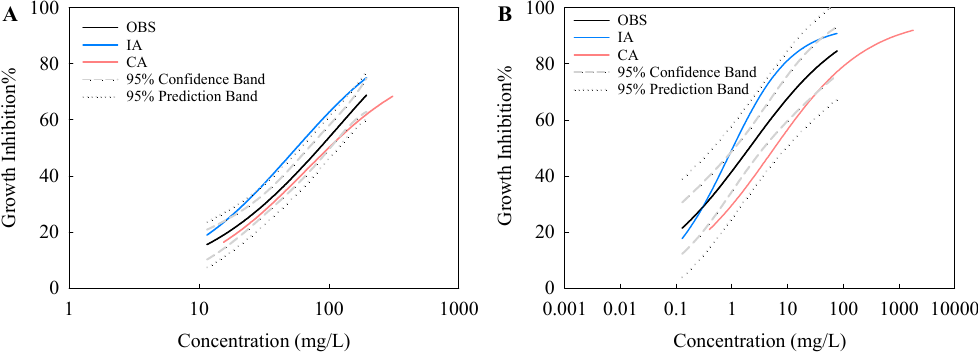
Figure 5. Comparison between regression models of the observed (OBS) combined nanotoxicity and expected toxicity of the mixtures to Scenedesmus obliquus ( A ) and Chlorella pyrenoidosa ( B ) according to concentration addition (CA) and independent action (IA). The dashed-line and dotted-line represent the 95% confidence band and 95% prediction band of the experimental data points, respectively.